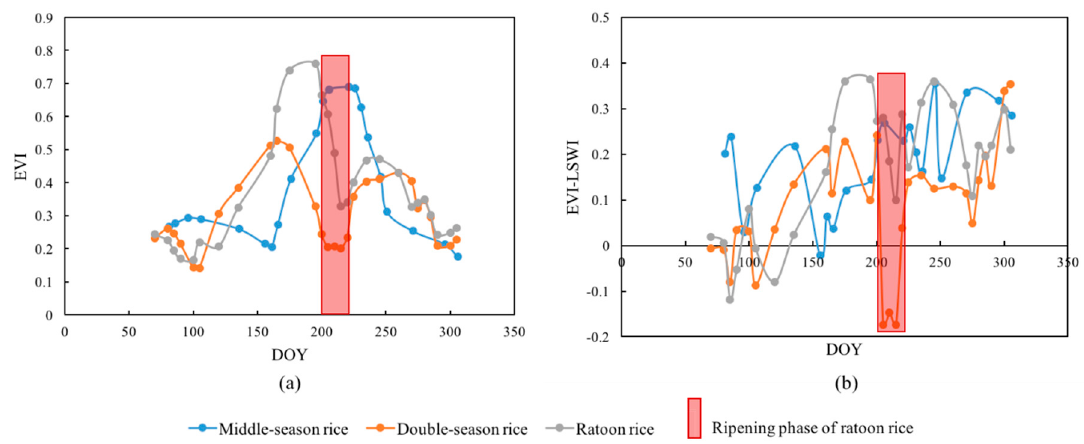
Figure 3. Time series of enhanced vegetation index (EVI) ( a ) and EVI–land surface water index (LSWI) ( a ) of middle-season rice, double-season rice, and ratoon rice.